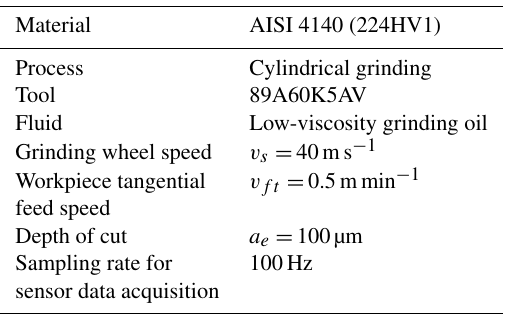
Table 1. Process parameters of the grinding process.